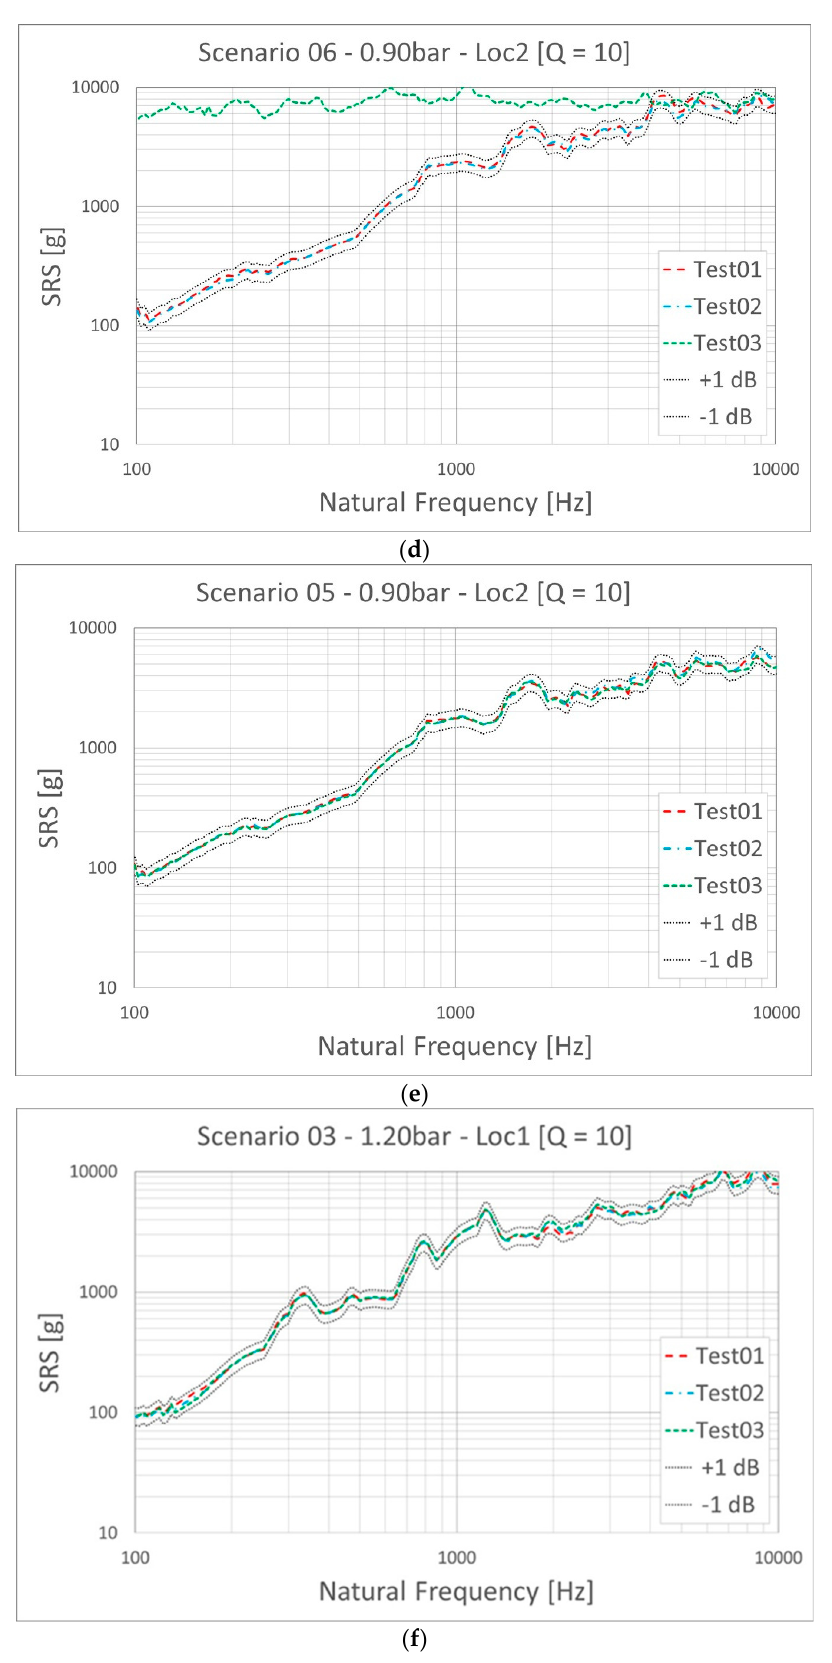
Figure 4. Experimental SRS results obtained from the tests. ( a ) Scenario 01, ( b ) Scenario 02, ( c ) Scenario 03, ( d ) Scenario 04, ( e ) Scenario 05, ( f ) Scenario 06.